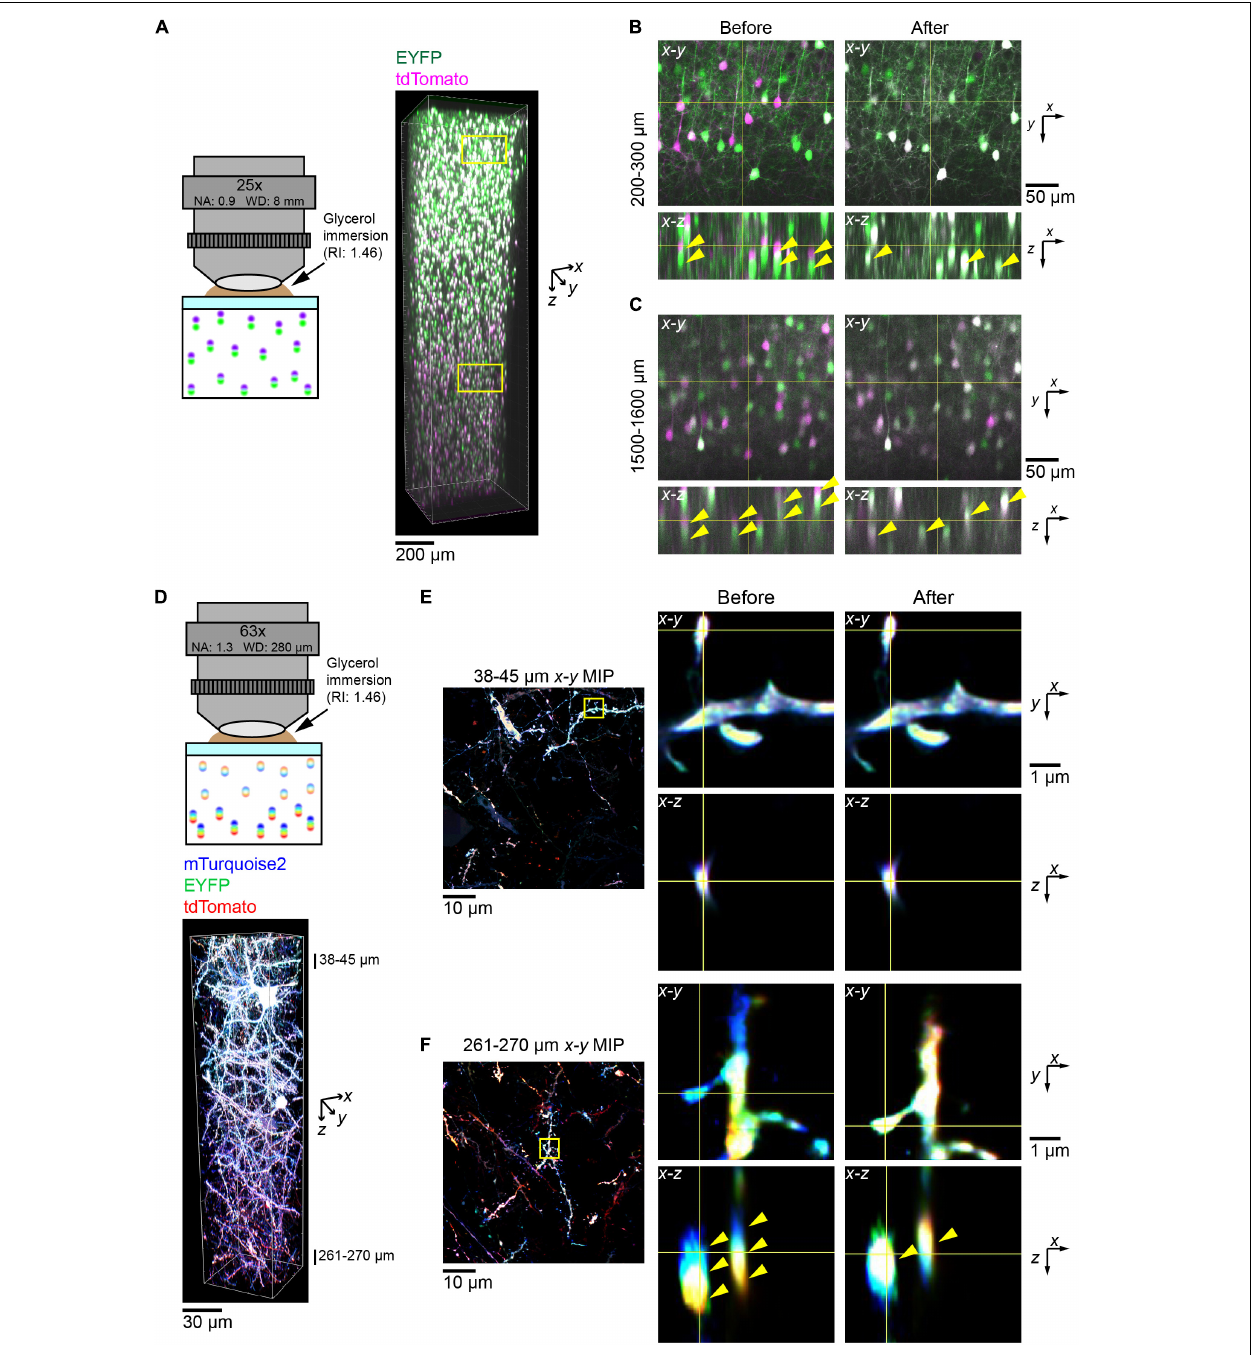
FIGURE 5 | Correction of chromatic aberration in a volumetric fluorescence image of the brain based on beads reference. (A) The post hoc correction of chromatic aberration for a 25 × objective lens. Fluorescence images of EYFP (excited at 473 nm) and tdTomato (559 nm) were aligned based on the bead data (from Figure 1 ) as described in Figure 4 . Neurons in the cerebral cortex were labeled by in utero electroporation at E15. A 2 mm thick coronal section was cleared with SeeDB2G. Age, P25. (B,C) Fluorescence images before and after the correction of chromatic aberrations. Signals for EYFP and tdTomato were separated before the correction but merged after the correction. Note that more doubly labeled neurons are present after the correction (yellow arrow heads). (D) The post hoc correction of chromatic aberration for a 63 × objective lens. Neurons were labeled with Tetbow (mTurquoise2, EYFP, and tdTomato), and a 300 µ m thick coronal section was cleared with SeeDB2G before imaging. Age, P101. (E,F) Fluorescence images in the shallow and deep areas before and after the post hoc correction. Using bead reference, chromatic aberration was corrected for brain sample images. Left panels display x – y maximum intensity projections over the specified z range, with the zoomed-in area highlighted by the yellow square. Right panels display orthogonal sections before (left) and after (right) the correction. Note that three different fluorescence channels were separated before the correction but fully merged after the correction in the deep area (yellow arrowheads).